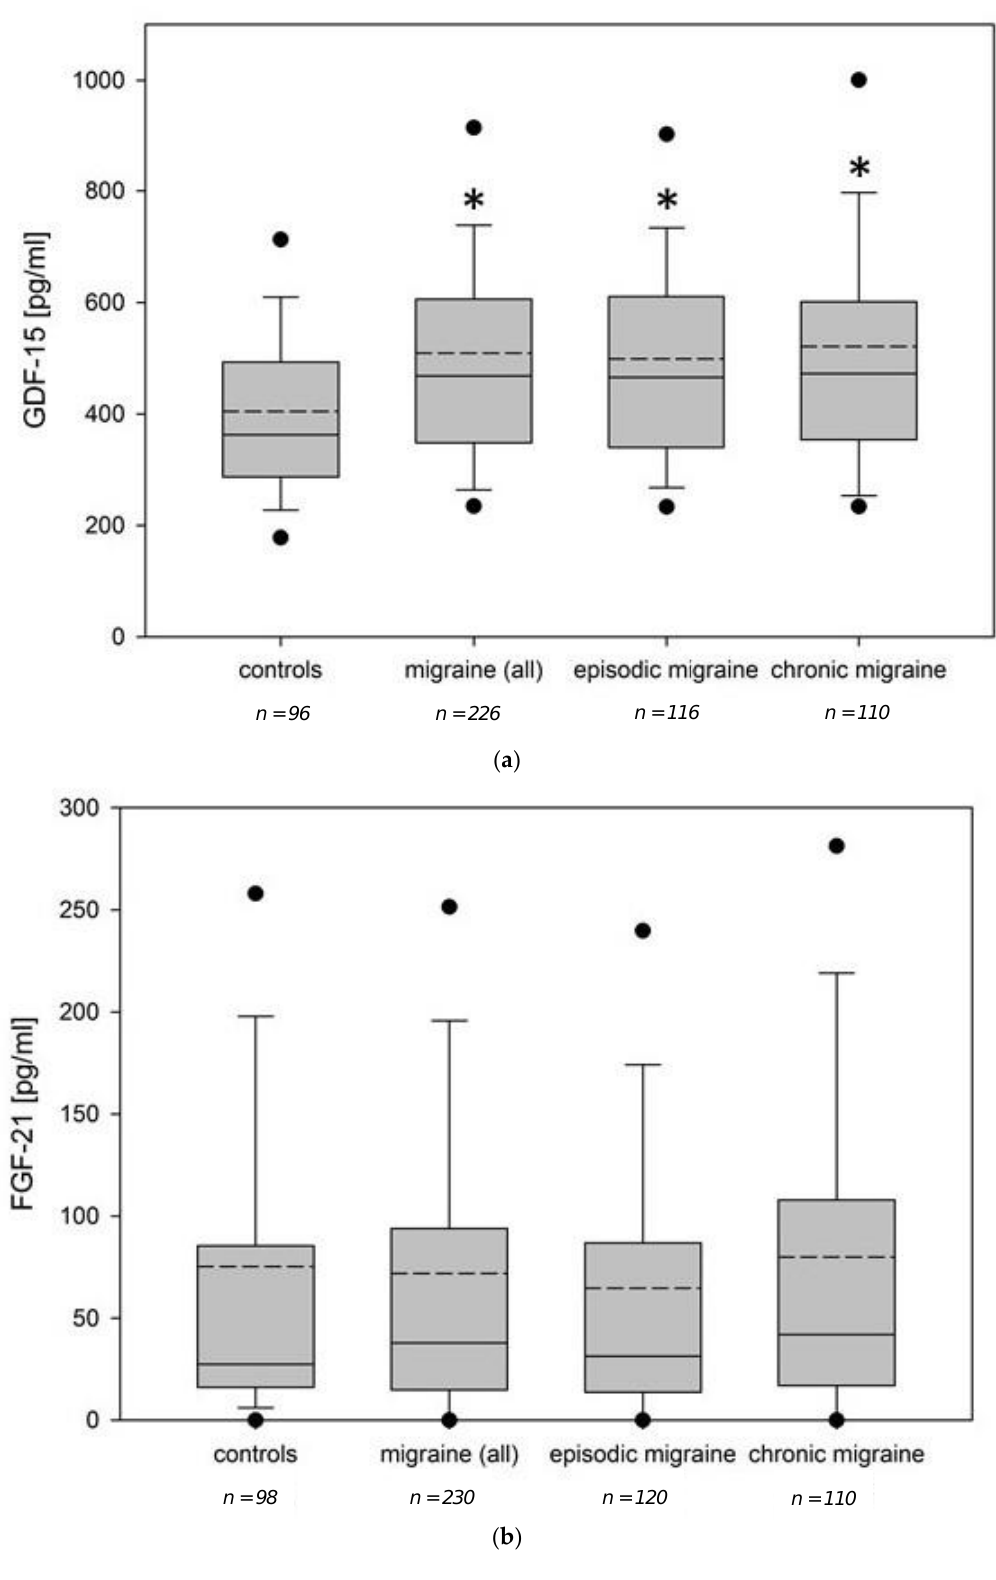
Figure 1. FGF-21- and GDF-15 values within the study groups. ( a ) FGF-21 and ( b ) GDF-15 values of all migraine patients, subgroups (EM and CM) and control subjects. Within the box plots, solid lines represent medians and dashed lines means. Outliers are displayed as 5–95% range (black dots). Groups that differed significantly ( p < 0.05) from the control group are marked with an